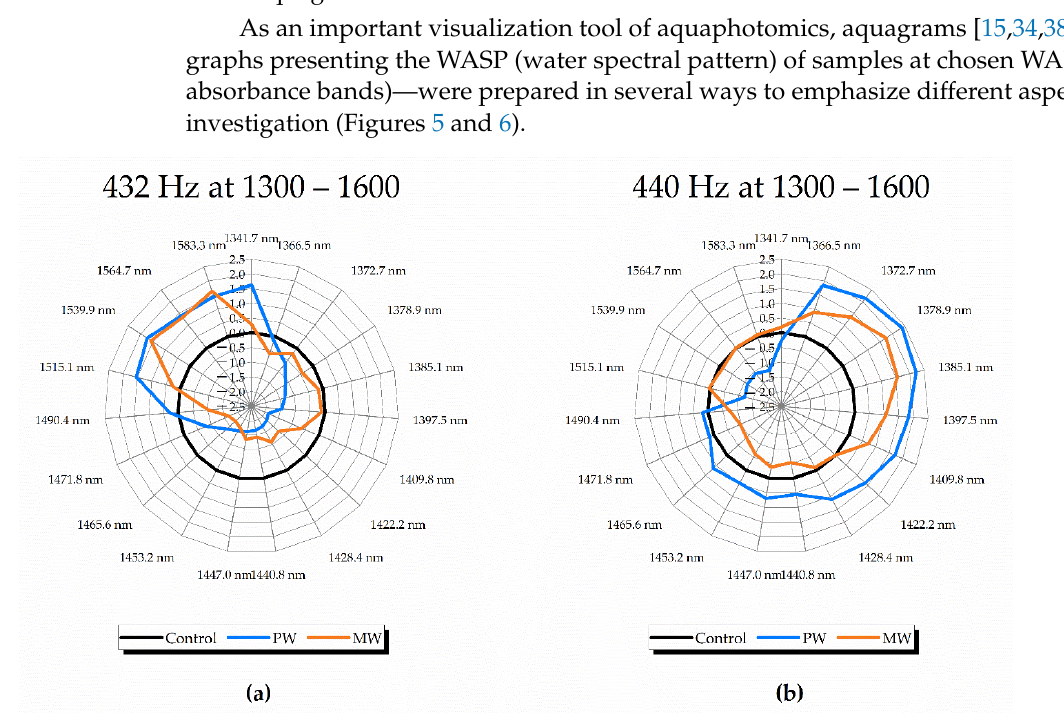
Figure 5. Aquagrams on waters, using prominent WABs from previous analyses, illustrating con- sistent WASPs at: ( a ) 432 Hz PW and MW at 1300–1600 nm with consistent WASP illustrated as increase in absorbance bands related to aqueous protons and strongly-bounded water; ( b ) 440 Hz PW and MW at 1300–1600 nm with a differently-consistent WASP characterized by higher concentration of water solvation shells, trapped and free water